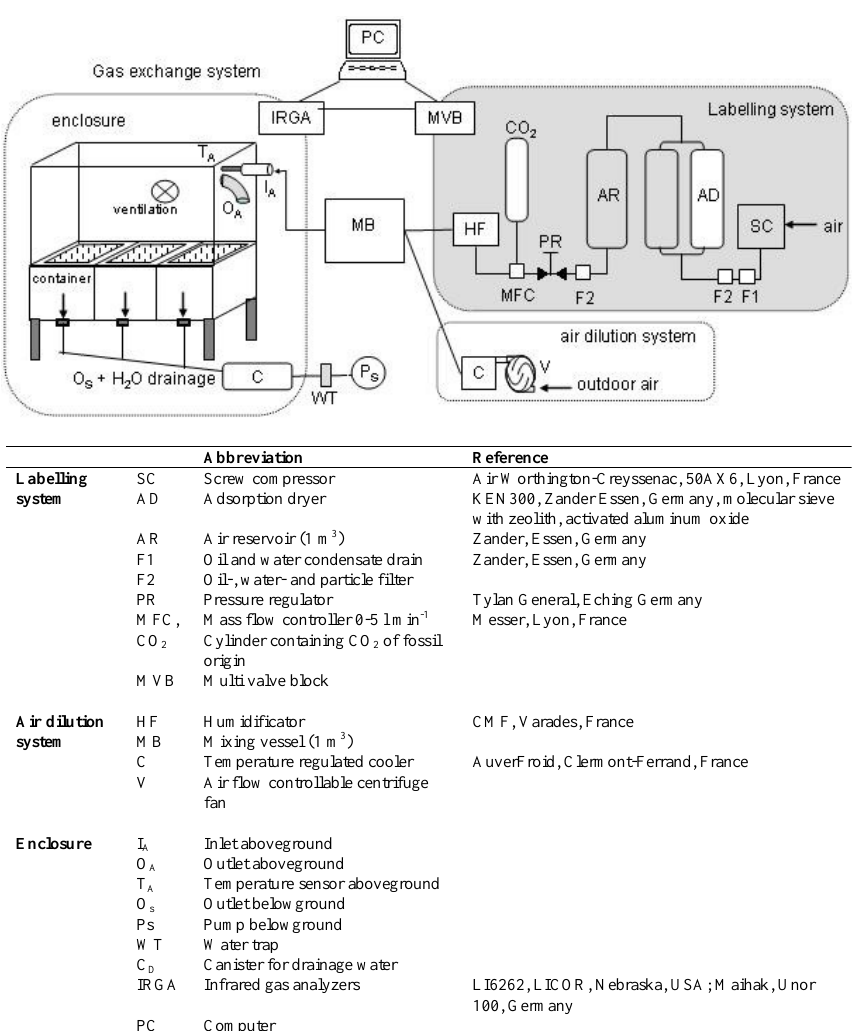
Fig. 1. Long term steady state 13 C labelling facility to investigate carbon turnover in plant-soil system